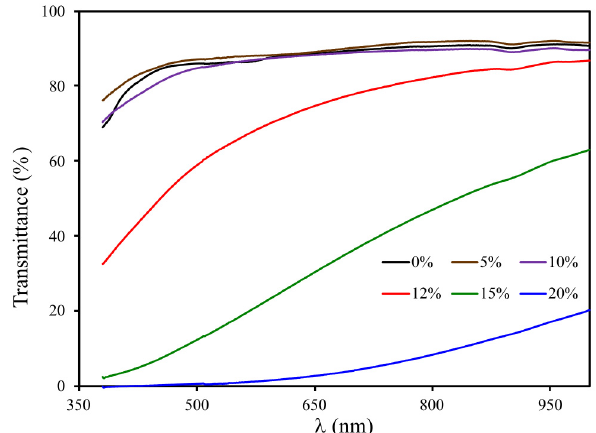
Figure 11. Transmission spectra of polyOCM-2 porous polymer monoliths depending on the content of the porogen 1-butanol (0–20 wt %).